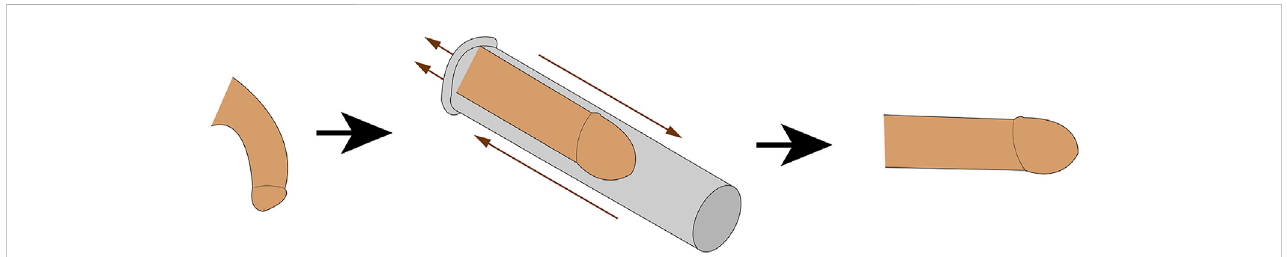
FIGURE 4 Mechanism of VED for the treatment of ED. Negative pressure dilates the cavernous sinuses, increasing their arterial and venous blood perfusion and ultimately achieving penile erection.